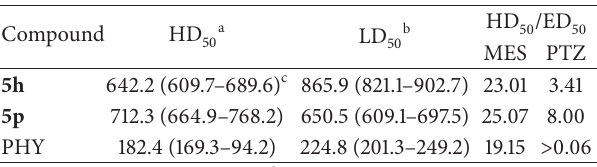
Table 4: Phase III quantitative toxicity profile of selected com- pounds.